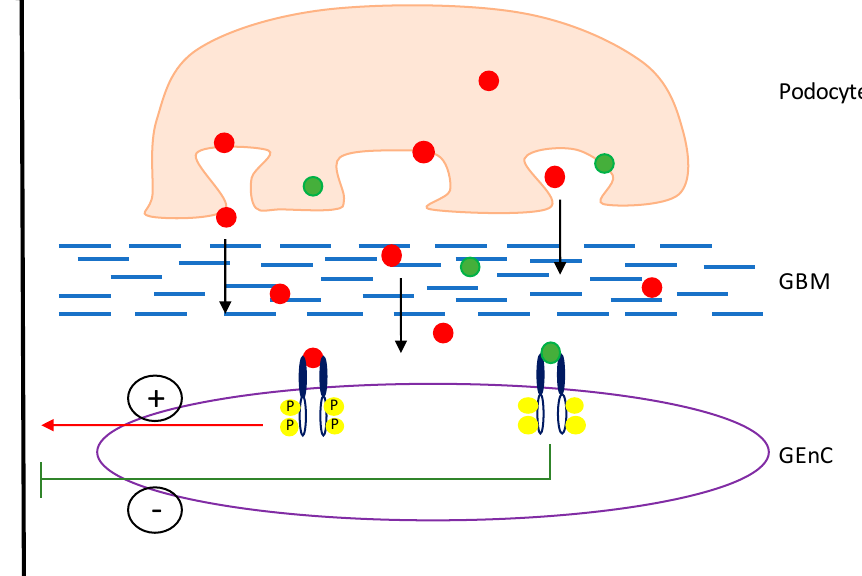
Figure 3. VEGF ‐ A signalling in the glomerulus. Both VEGF ‐ A xxx (red dots) and VEGF ‐ A xxx b (green dots) are expressed by the podocytes and diffuse through the glomerular basement membrane (GBM) to bind to VEGFR2 on the glomerular endothelial cells (GEnCs), against the flow of filtrate. Upon binding of VEGF ‐ A xxx to VEGFR2, the receptor is phosphorylated, initiating a pro ‐ permeability response. However, upon binding of VEGF ‐ A xxx b to VEGFR2, the receptor is not activated and an anti ‐ permeability response is initiated.